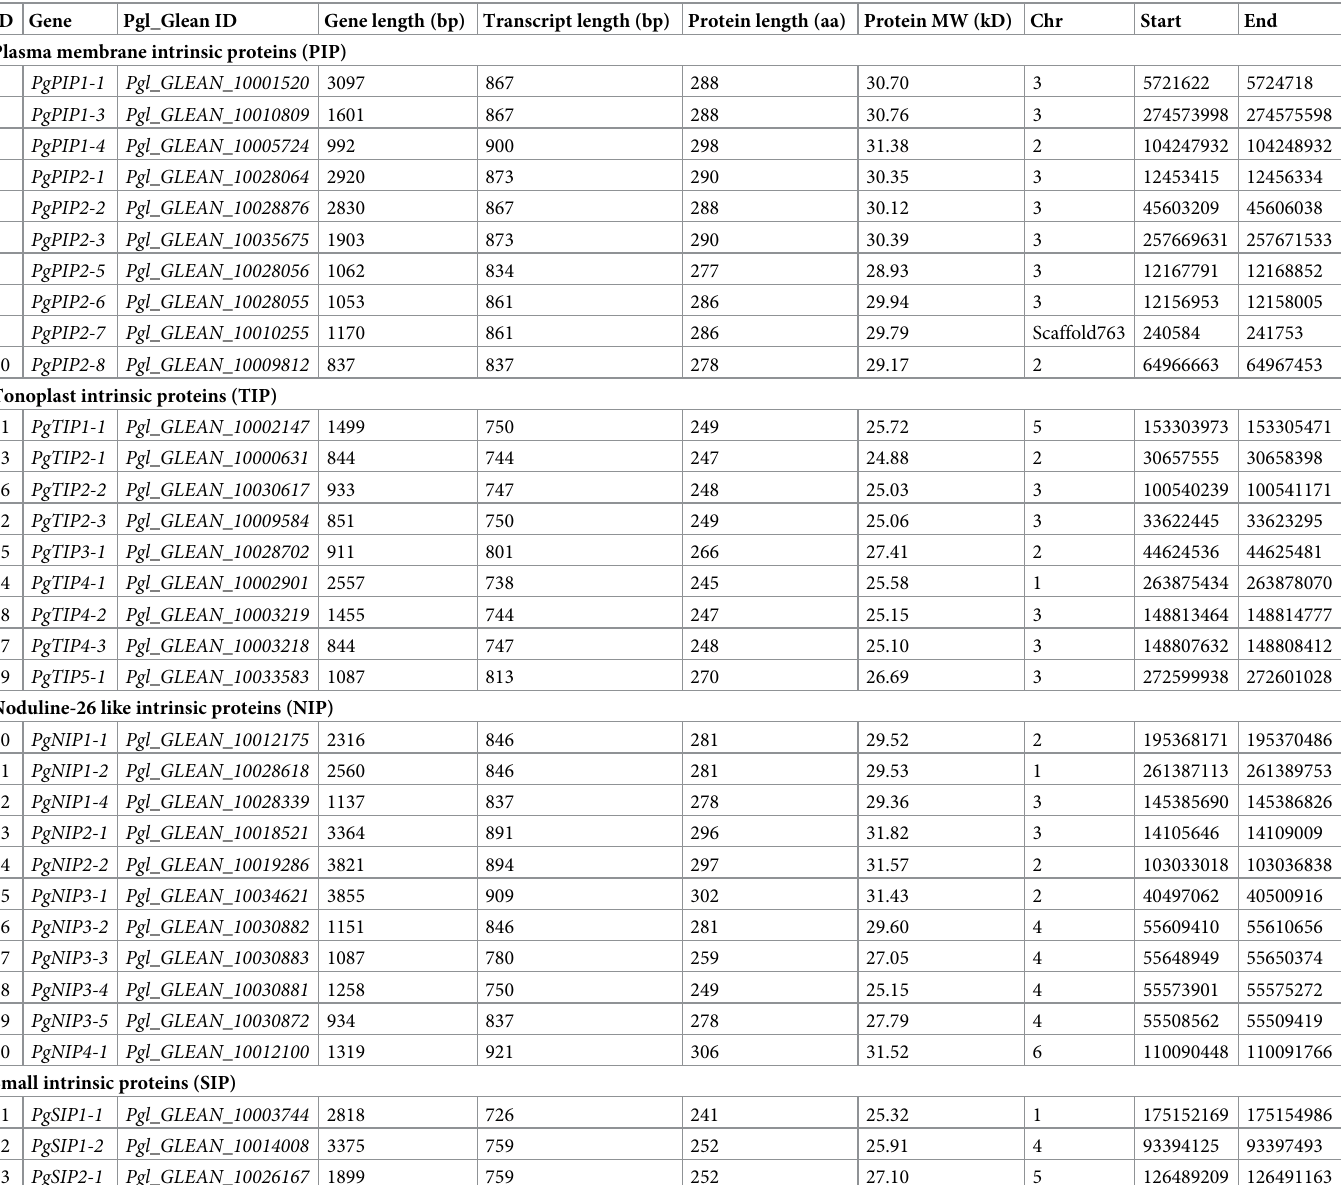
Table 1. Description and distribution of pearl millet aquaporin